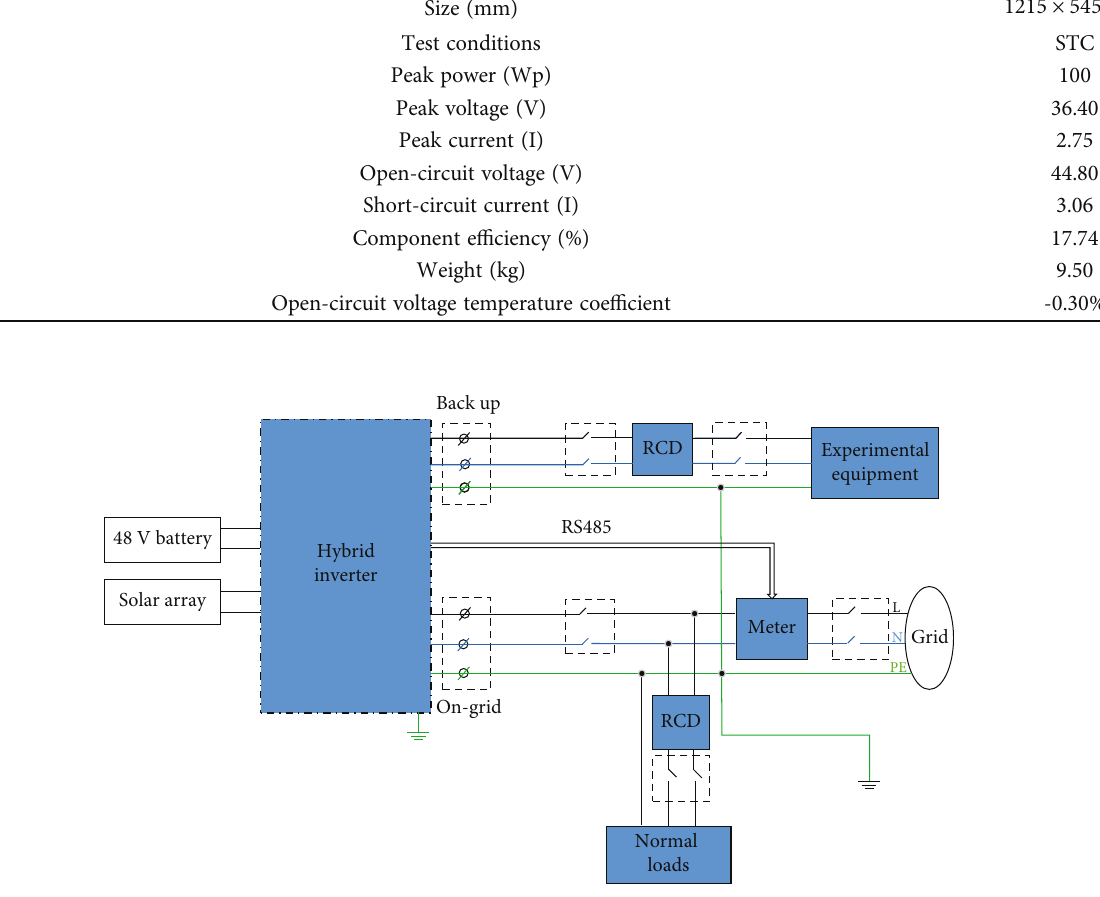
Figure 5: Wiring diagram of the electrical